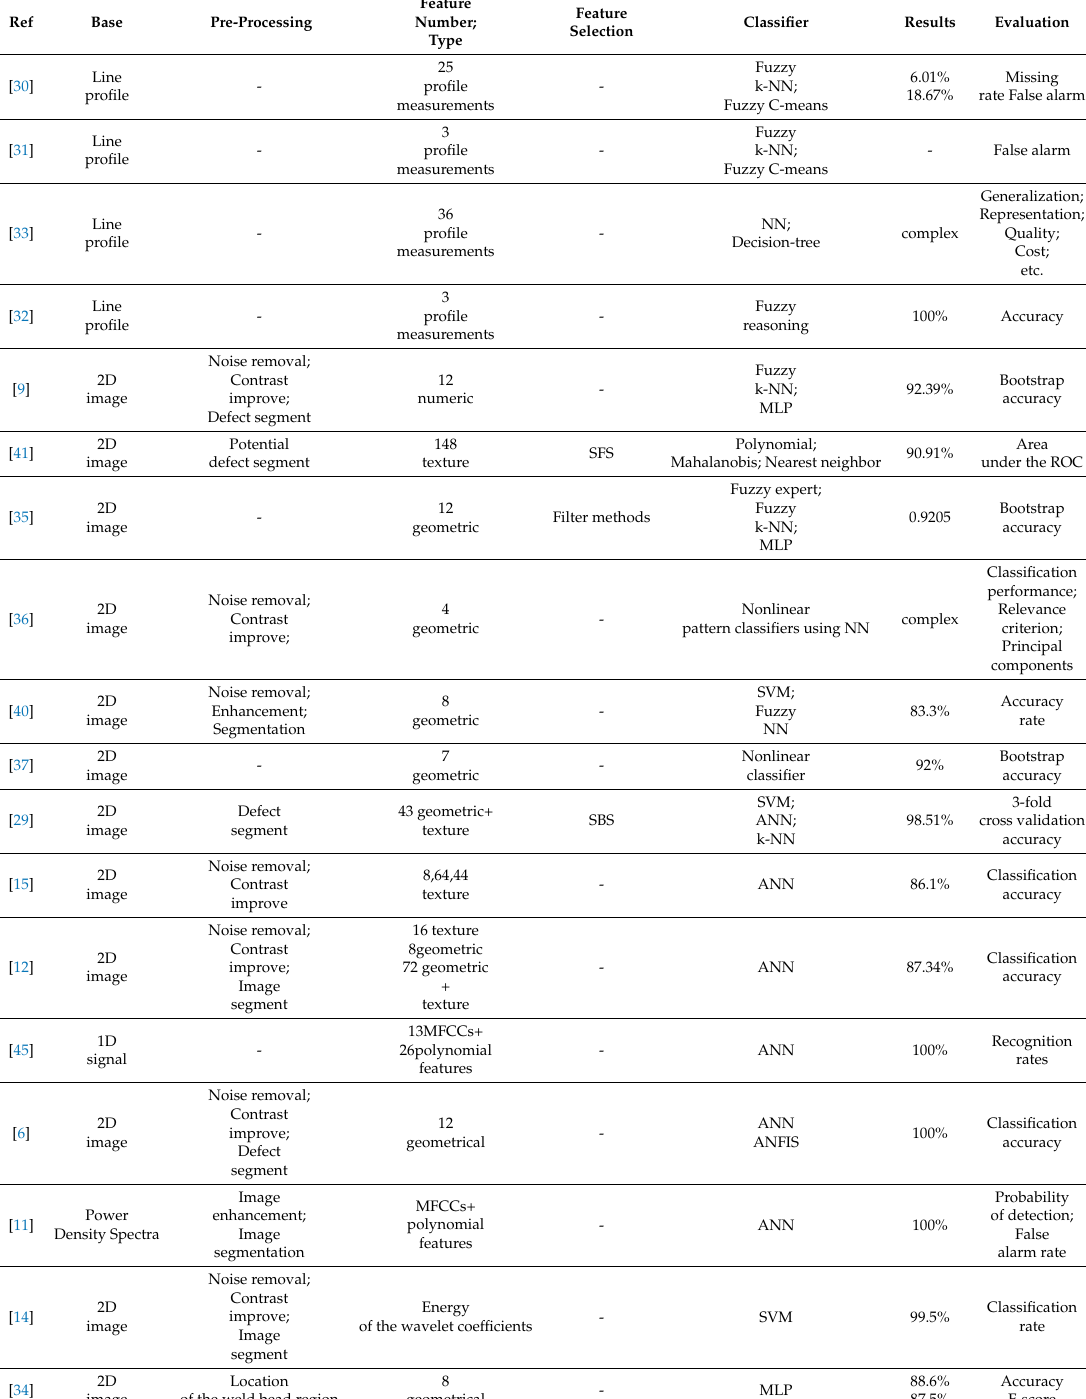
Table 1. Main techniques used in the papers cited for readers